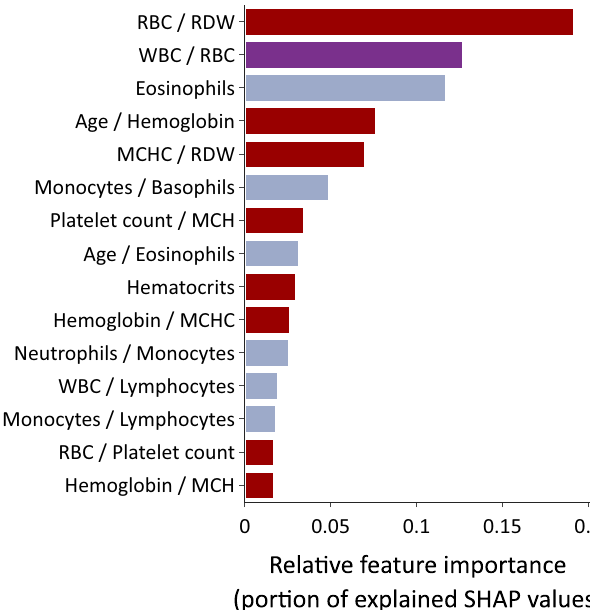
Fig. 2 Analyte feature importance of the COVID-19 specialized model. Features in red are exclusively from the red series (roughly 60% of total importance). Features in gray are exclusively from the white series (roughly 26% of total importance). Features in purple involve analytes from both red and white series (roughly 14% of total importance). N = 103,822